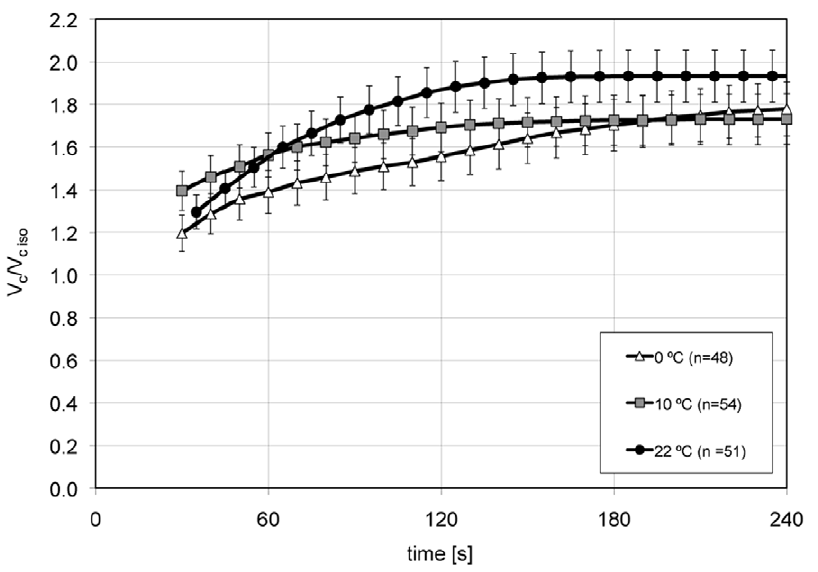
Figure 4. Normalized swell curves of COS-7 cells in hypotonic (157 mOsm/kg) TBS. The data represent averages and S.E. values of 205 individually measured cells. Cells reached their equilibrium volume faster the higher the temperatures. However, these times were significantly longer than in the hyperosomotic situation for all three temperatures tested.